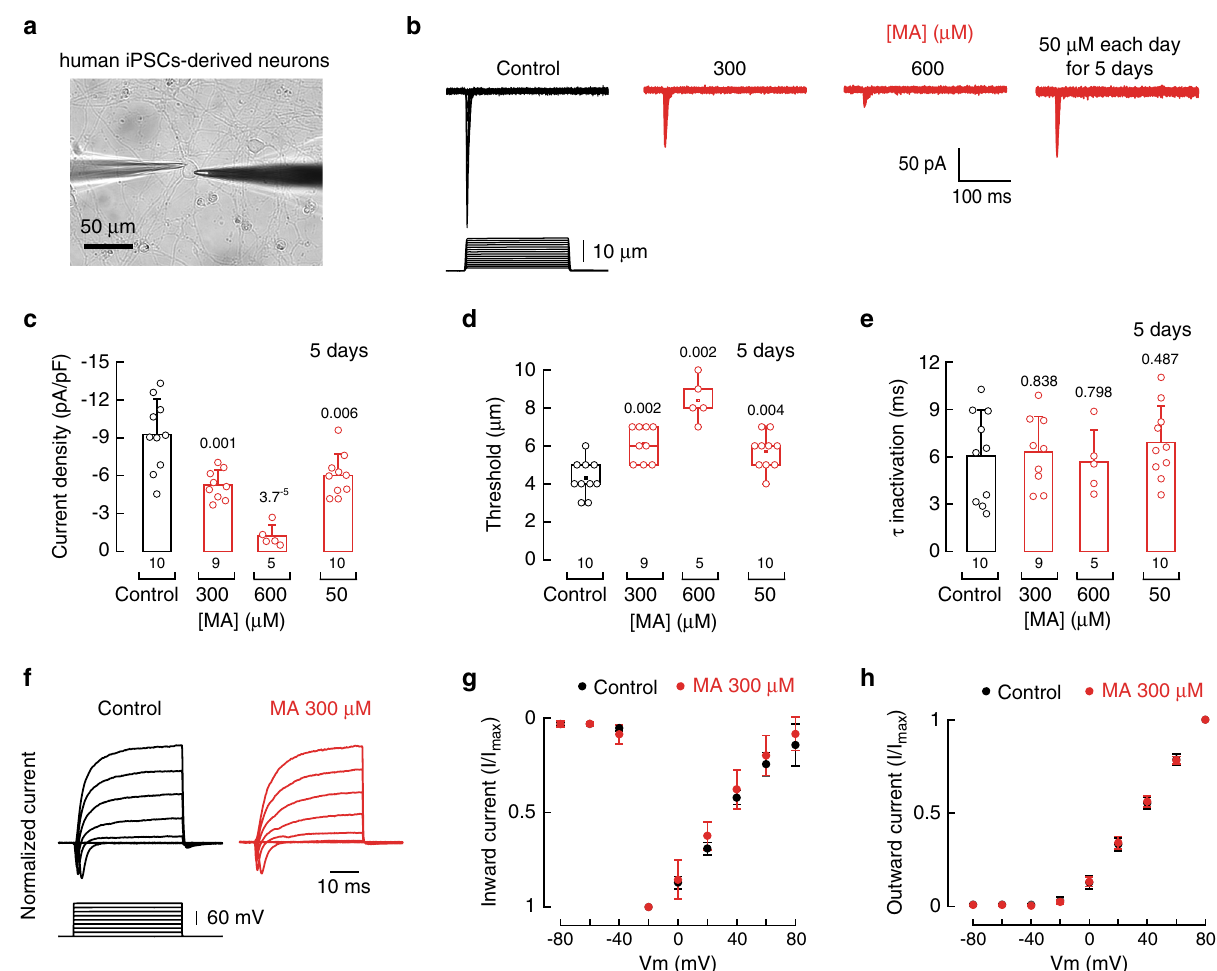
Fig. 7 MA decreases mechano-activated currents in human iPSCs-derived neurons. a Micrograph of a human iPSCs-derived neuron in the whole-cell patch-clamp con fi guration ready for mechanical stimulation. Micrograph is representative of at least 10 independent preparations. b Representative whole- cell patch-clamp traces of mechanically activated currents of control and MA (300 and 600 μ M for 18 h and 50 μ M each day for 5 days)-treated iPSC- derived neurons. c Current densities elicited by maximum displacement of control and MA (300 and 600 μ M for 18 h and 50 μ M each day for 5 days)- treated iPSC-derived neurons. Bars are mean ± SD. n is denoted above the x -axis. Two-tailed unpaired t -test. d Displacement thresholds required to elicit currents of control and MA (300 and 600 μ M for 18 h and 50 μ M each day for 5 days)-treated iPSC-derived neurons. Boxplots show mean (square), median (bisecting line), bounds of box (75 th to 25 th percentiles), outlier range with 1.5 coef fi cient (whiskers), and minimum and maximum data points. n is denoted above the x -axis. Two-tailed Mann – Whitney test for control and 300 μ M MA and control and 600 μ M MA, and two-tailed unpaired t -test for control and 50 μ M for 5 days. e PIEZO2 time constant of inactivation elicited by maximum displacement of control and MA (300 and 600 μ M for 18 h and 50 μ M each day for 5 days)-treated iPSC-derived neurons. Bars are mean ± SD. n is denoted above the x -axis. Two-tailed unpaired t-test. f Representative whole-cell patch-clamp recordings of control and MA (300 µ M)-treated iPSC-derived neurons depolarized in a stepwise manner from a membrane potential of − 80 mV. g Normalized inward current densities elicited by stepwise depolarization from − 80 mV of control and MA (300 µ M)-treated DRG neurons. Circles are mean ± SD. n = 8. h Normalized outward current densities elicited by stepwise depolarization from − 80 mV of control and MA (300 µ M)-treated DRG neurons. Circles are mean ± SD. n = 8. p -values are denoted above the bars and